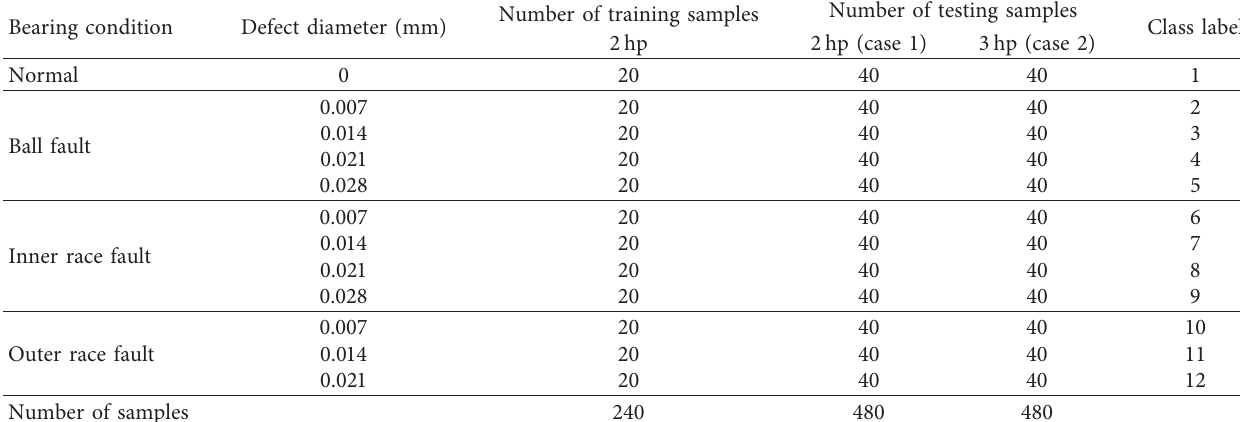
Table 2: The detailed information of the first group dataset.